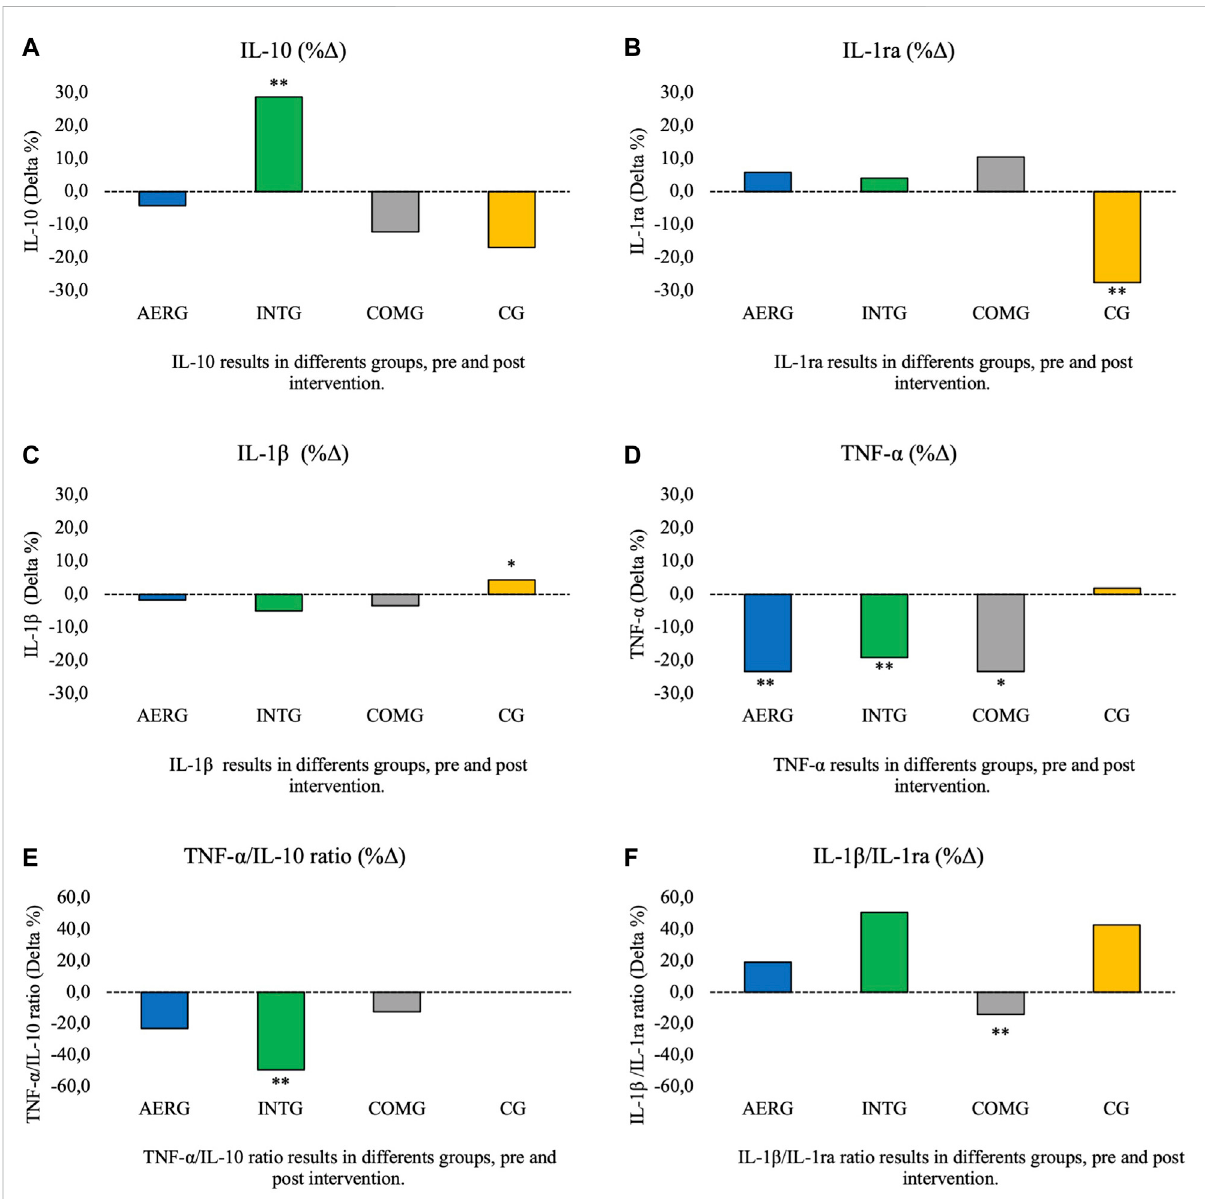
FIGURE 4 Percentage of difference post-pre intervention for cytokines IL-10, IL-1ra, IL-1 β , TNF- α and in fl ammatory index TNF α -/IL-10, IL-1 β /IL-Ira.